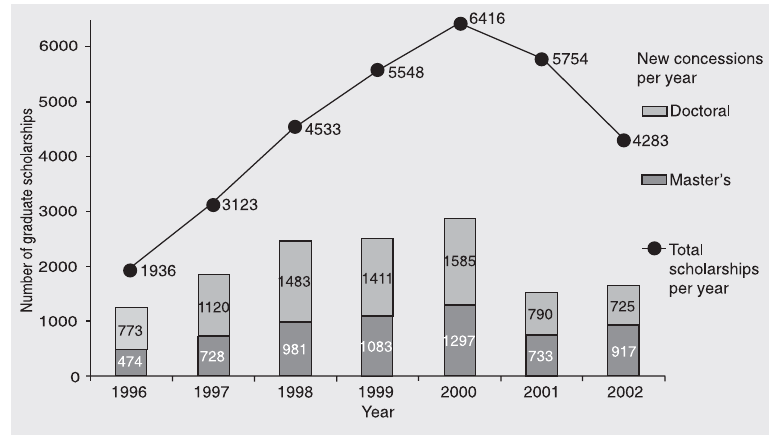
Figure 9. Number of new Master’s and Doctoral schol- arships awarded by FAPESP, and total number of cur- rent graduate scholarships per year between 1996 and 2002 (original data source: FAPESP, http://www.